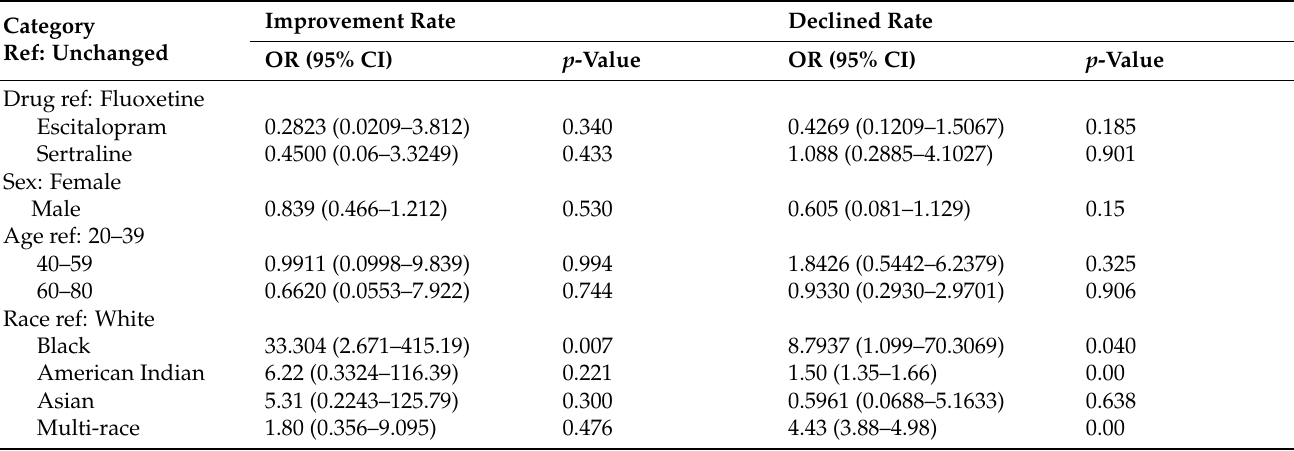
Table 3. Multinomial logistic regression to predict improvement in K6 scores among SSRIs